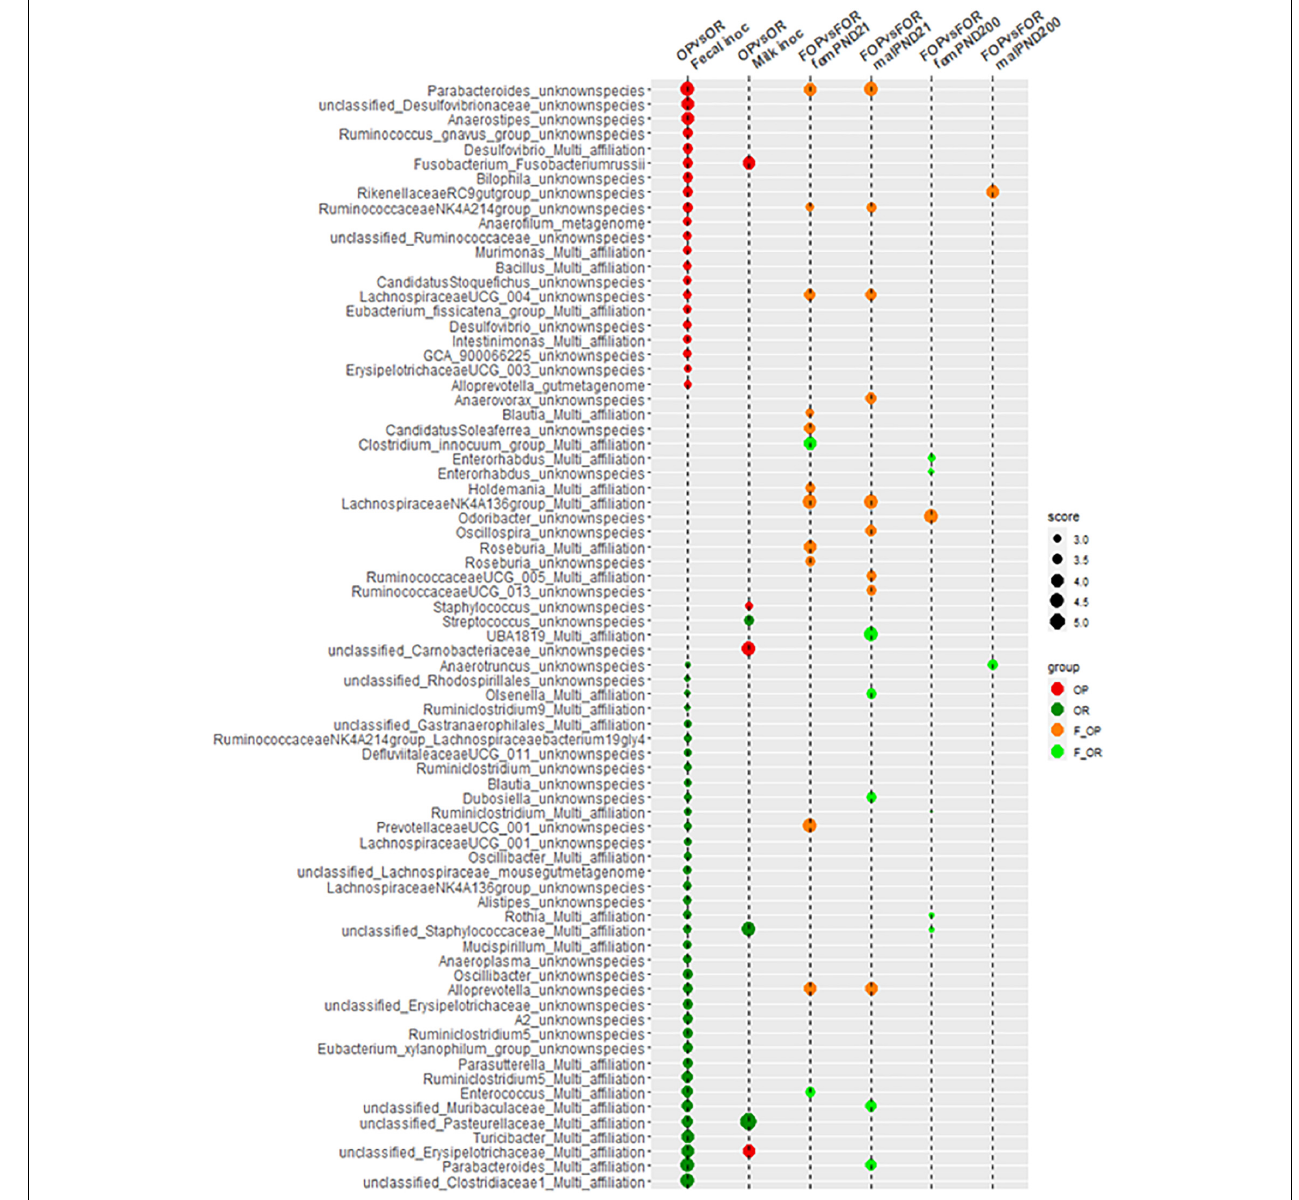
FIGURE 4 | Compilation, at the bacterial species level, of the LDA scores obtained during comparisons carried out between inocula and between F344